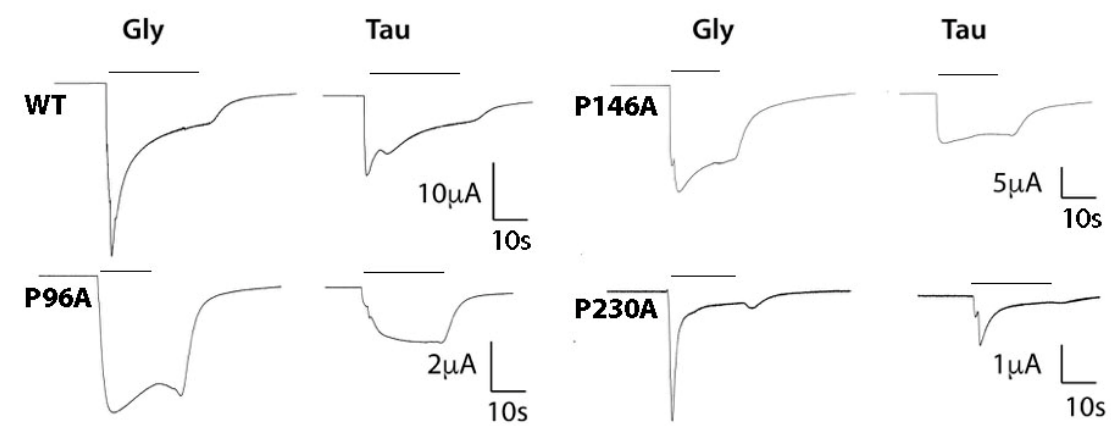
Figure 3. Typical Gly (1 mM) and Tau (10 mM)-induced traces for WT and mutant receptors expressed in oocytes and clamped at − 60 mV. Bars indicate agonist application. The different shapes of the responses suggest the mutations may alter receptor kinetics (e.g., desensitization, association and/or dissociation rates). Table 1. Parameters derived from WT and mutant GlyR expressed in oocytes. Gly